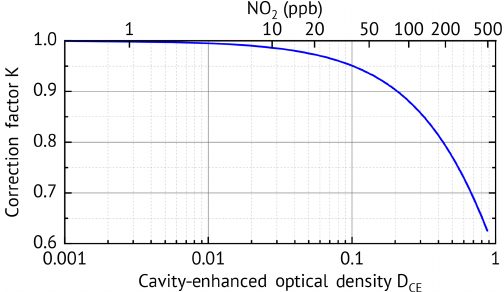
Figure 3. Correction factor K as a function of the cavity-enhanced optical density D CE . Note that the correction factor is also wave- length dependent as the optical density D CE (λ) is wavelength de-